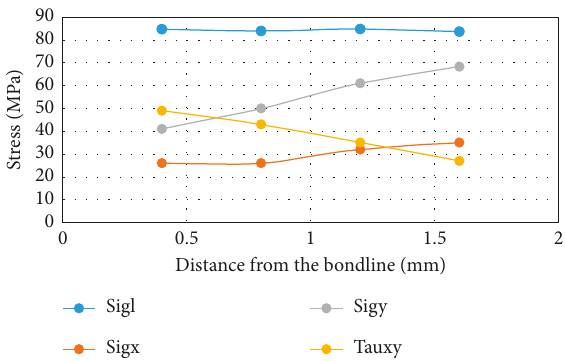
Figure 14: The dependence between maximum stresses in the joints and the distance of the impactor’s edge to the bondline (SigI (cid:136) Max Principal Stresses; Sigy (cid:136) normal stresses perpendicular to the surface of the joint; Tauxy (cid:136) tangential stresses in the direction of impact